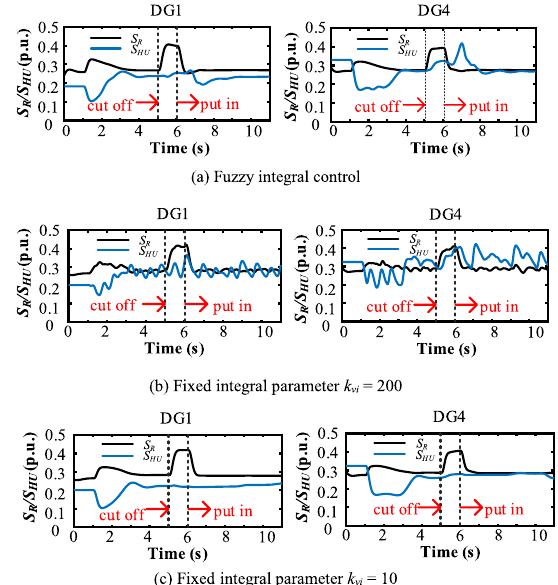
Fig. 21 The residual capacity and S HU of DG 1 and 4 under load switching